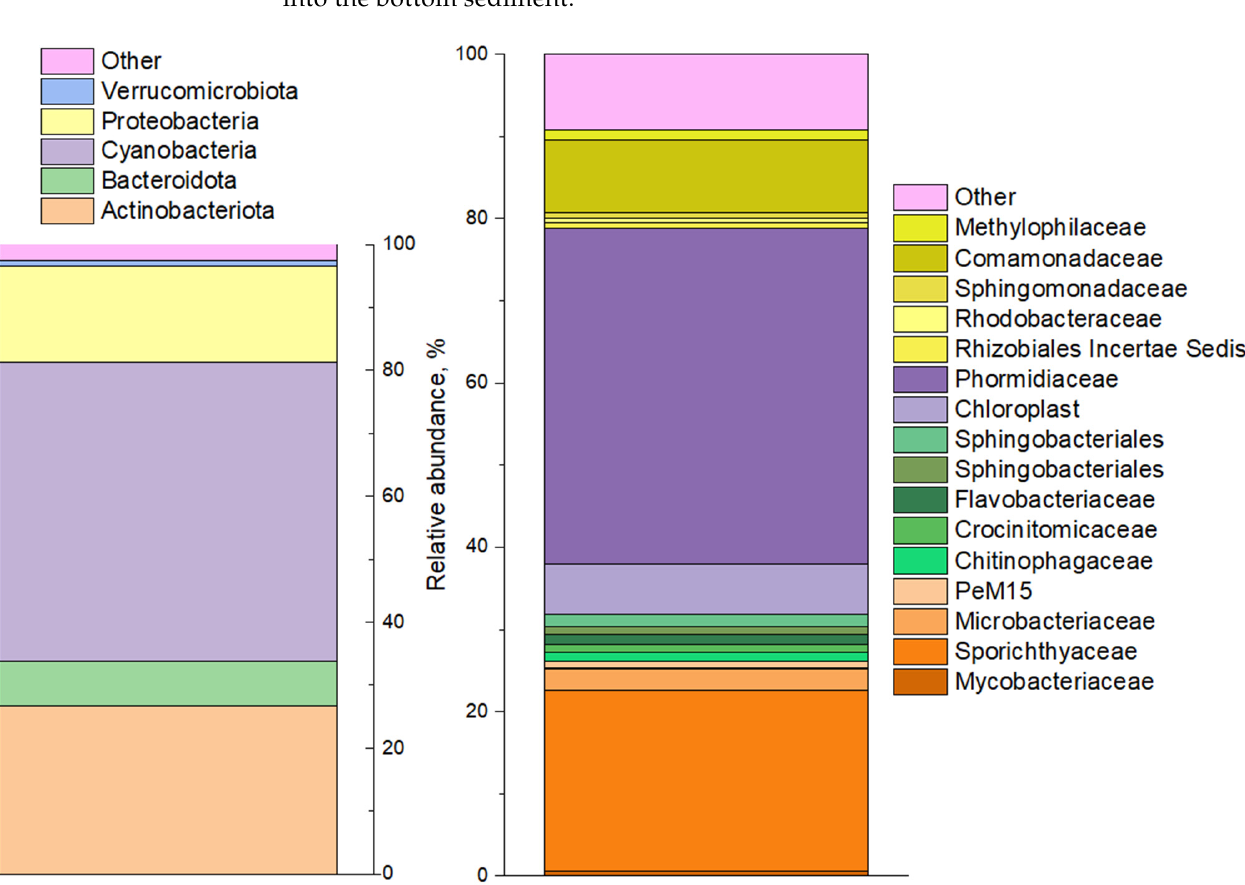
Figure 2. Prokaryotic community diversity profile of the phytoplankton community by 16SrRNA genes (phylum level shown on left, and familia level shown on right).